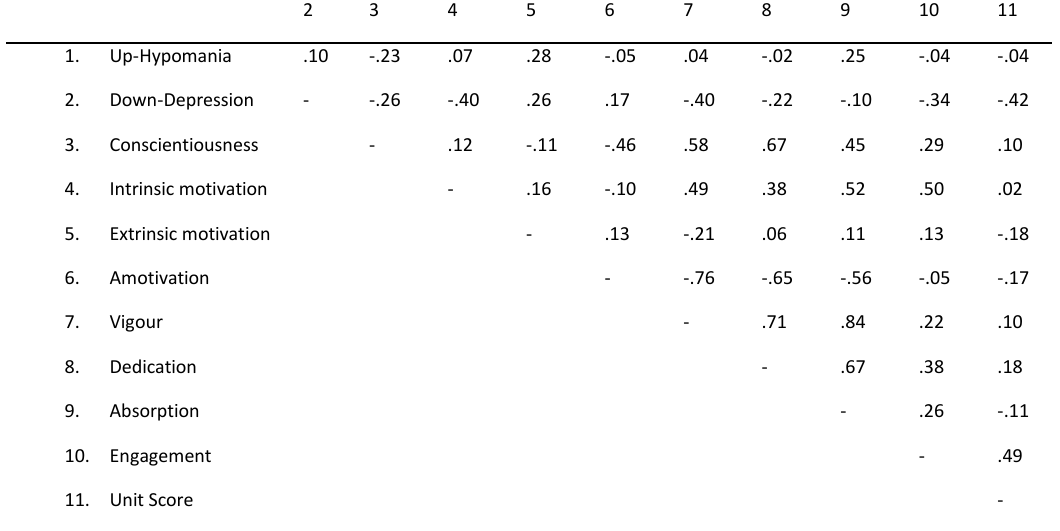
Correlations between Predictor and Outcome Variables in the Follow-up Sample (n =